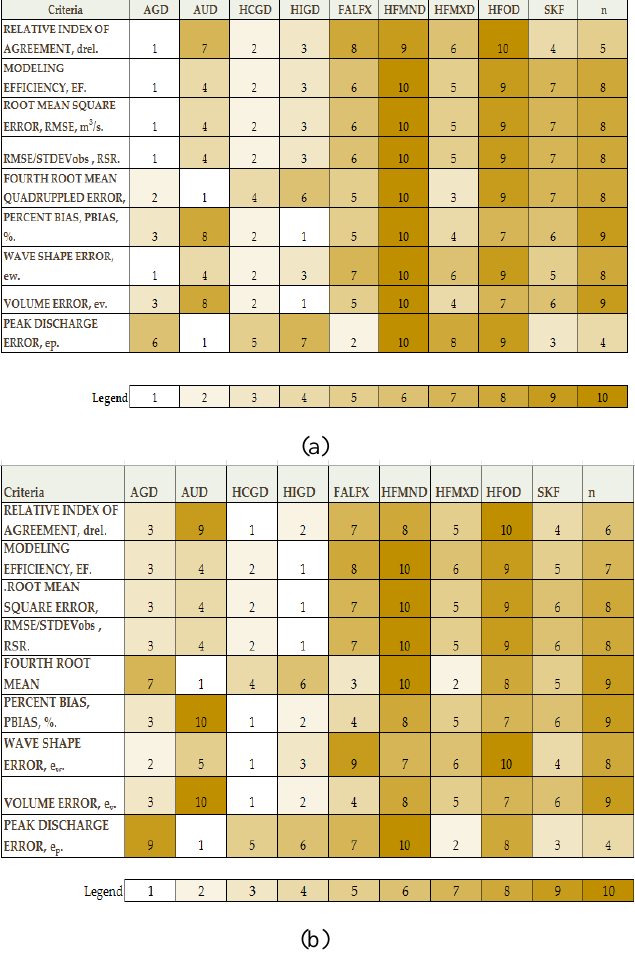
Fig. 12. Parameter ranking based on slope of performance Fig. 11. Sensitivity indices of parameters variation at plots (a) Jhelum river basin (b) Chenab river different flow regimes amplification factor for Chenab river basin